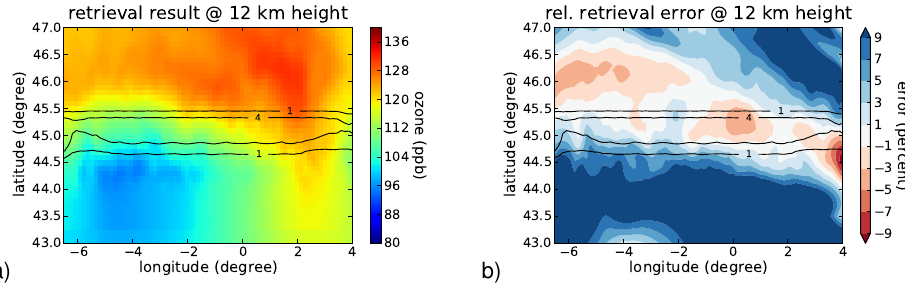
Fig. 4. The retrieval result for a linear flight track. Panel (a) shows the retrieved ozone concentrations. The relative error of the retrieval is plotted in (b) . The number of tangent points within the depicted volume elements is overlaid as a contour plot.